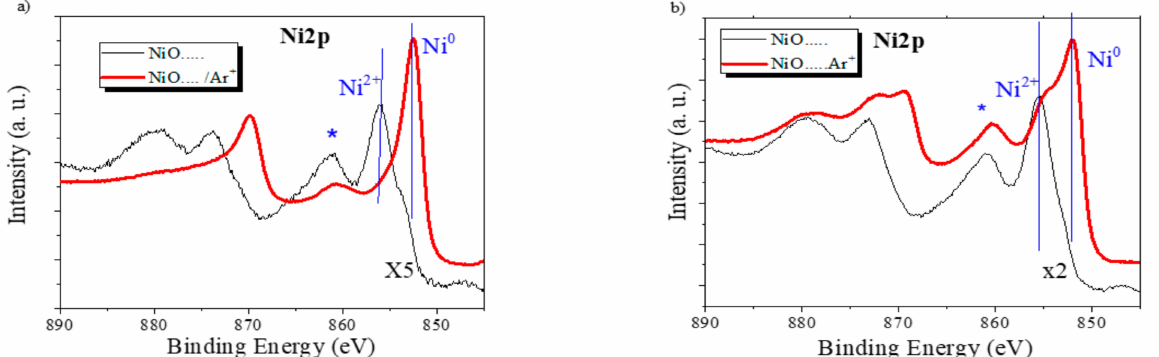
Figure 7. The Ni2p photoelectron spectra of the NiO-0V sample ( a ) and the NiO-3V sample ( b ) before (thin black line) and after (red thick line) a mild sputtering with Ar+. (Note that the spectra before sputtering have been multiplied by the factors indicated in the plot). The Ni2p3/2 features associated with Ni 0 and Ni 2+ and a satellite that is particularly intense for the Ni 2+ species (marked with an asterisk) are highlighted in the plots.